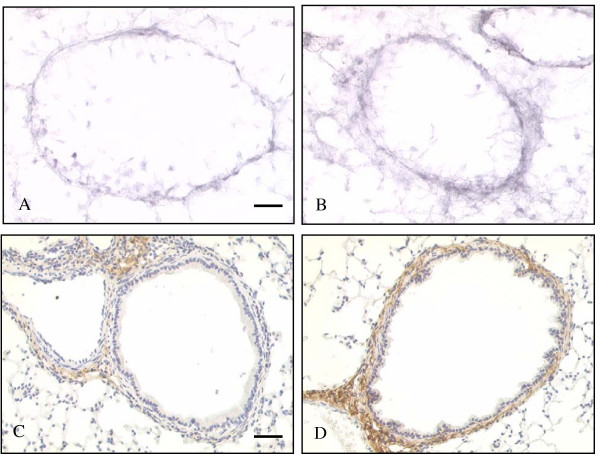
The effect of ovalbumin sensitisation and challenge on airway sub-epithelial proteoglycan and decorin deposition. Cupromeronic Blue staining of representative airways from (A) control and (B) ovalbumin sensitised/challenged airways 12 days after final challenge. The reticular pattern of staining is seen particularly around the airway circumference in a distribution corresponding to the sub-epithelial layer. Staining is greater in ovalbumin sensitised/challenged airways. Decorin immunostaining of representative airways from (C) control and (D) ovalbumin sensitised/challenged airways at the same time point. Immunostaining is concentrated in the walls of airways and vessels and is not seen in the lung parenchyma. Immunostaining is greater in ovalbumin sensitised/challenged airways and vessels. Scale bars represent 50 μm.